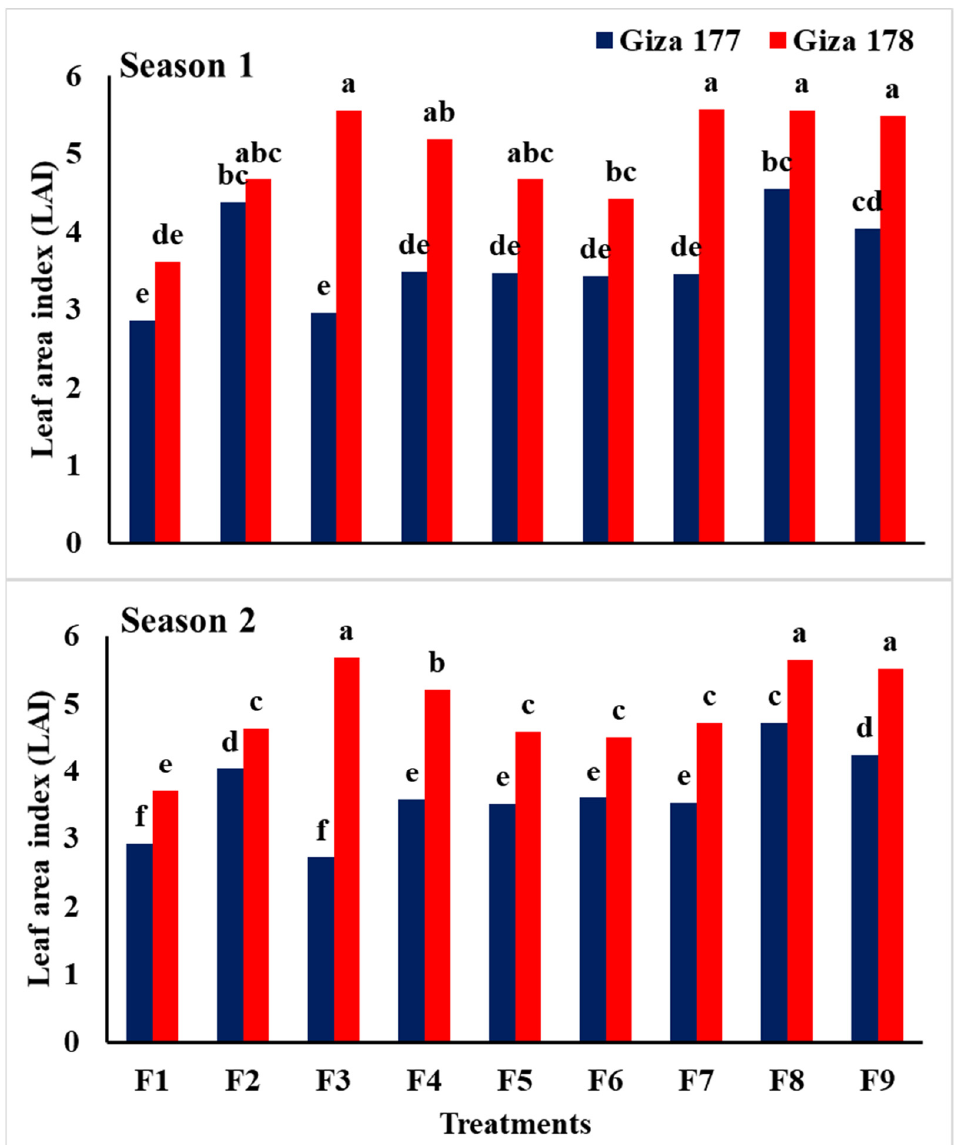
Figure 1. Interaction effect of NPs-Si and NPs-Se treatments on leaf area index (LAI) of the two rice varieties under saline soil conditions during the first and second seasons. F1 = control; F2 = soaking-NPs-Si; F3 = soaking-NPs-Se; F4 = foliar-NPs-Si at MT; F5 = foliar-NPs-Se at MT; F6 = foliar-NPs-Si at PI; F7 = foliar-NPs-Se at PI; F8 = foliar-NPs-Si at BT; F9 = foliar-NPs-Se at BT; NPs-Si = nanoparticles of silicon; NPs-Se = nanoparticles of selenium, MT = mid tillering stage; PI = panicle initiation; BT = mid booting stage. Means followed by the same letter were not significantly different for probability ( p ) ≤ 0.05.